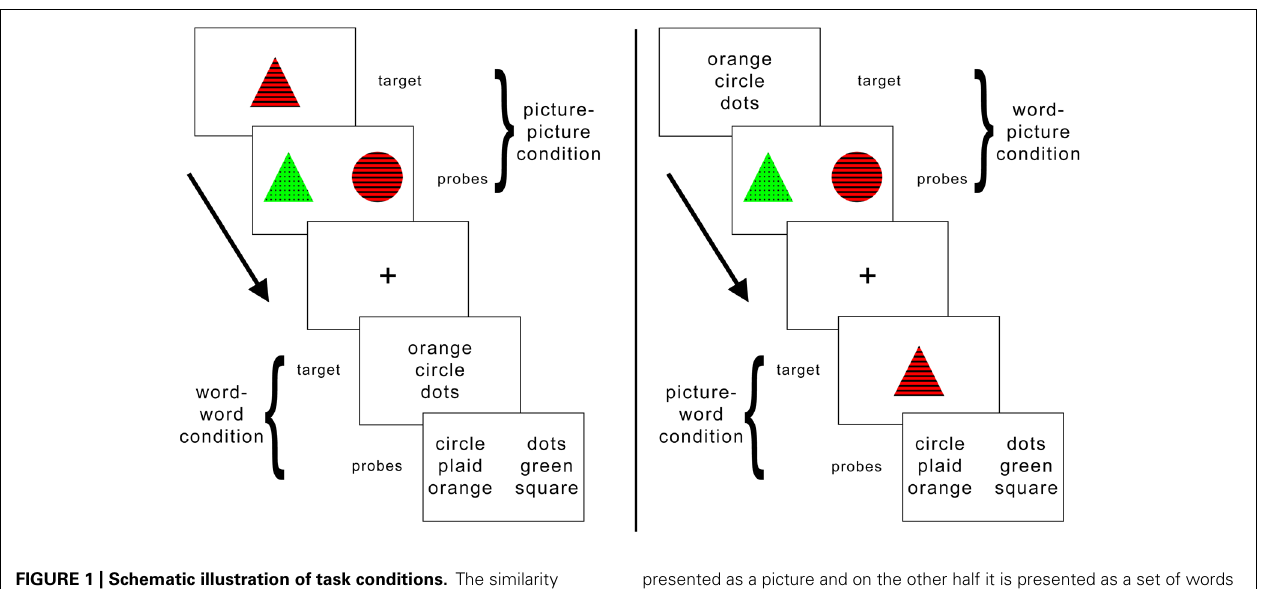
FIGURE 1 | Schematic illustration of task conditions. The similarity judgment requires memory and comparison of a target item to two subsequently presented probe items. On half of the trials the target item is